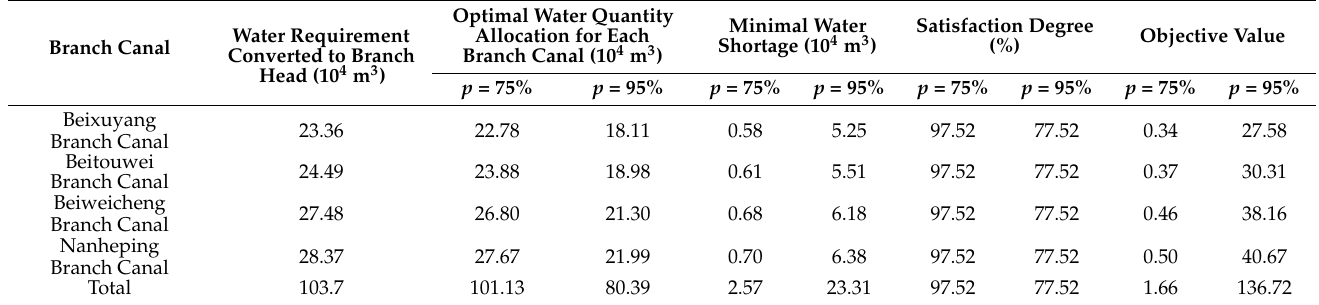
Table 5. Water quantity allocation of each branch canal in the Hengliu Main Canal system during the ponding period of rice in different year types using